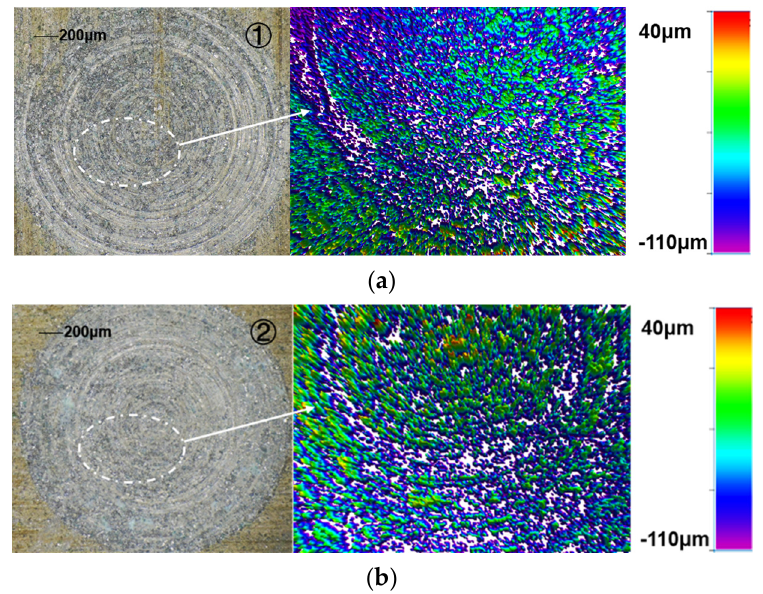
Figure 10. Effect of different control systems on machining results: ( a ) manual control; ( b ) auto-tuning control.